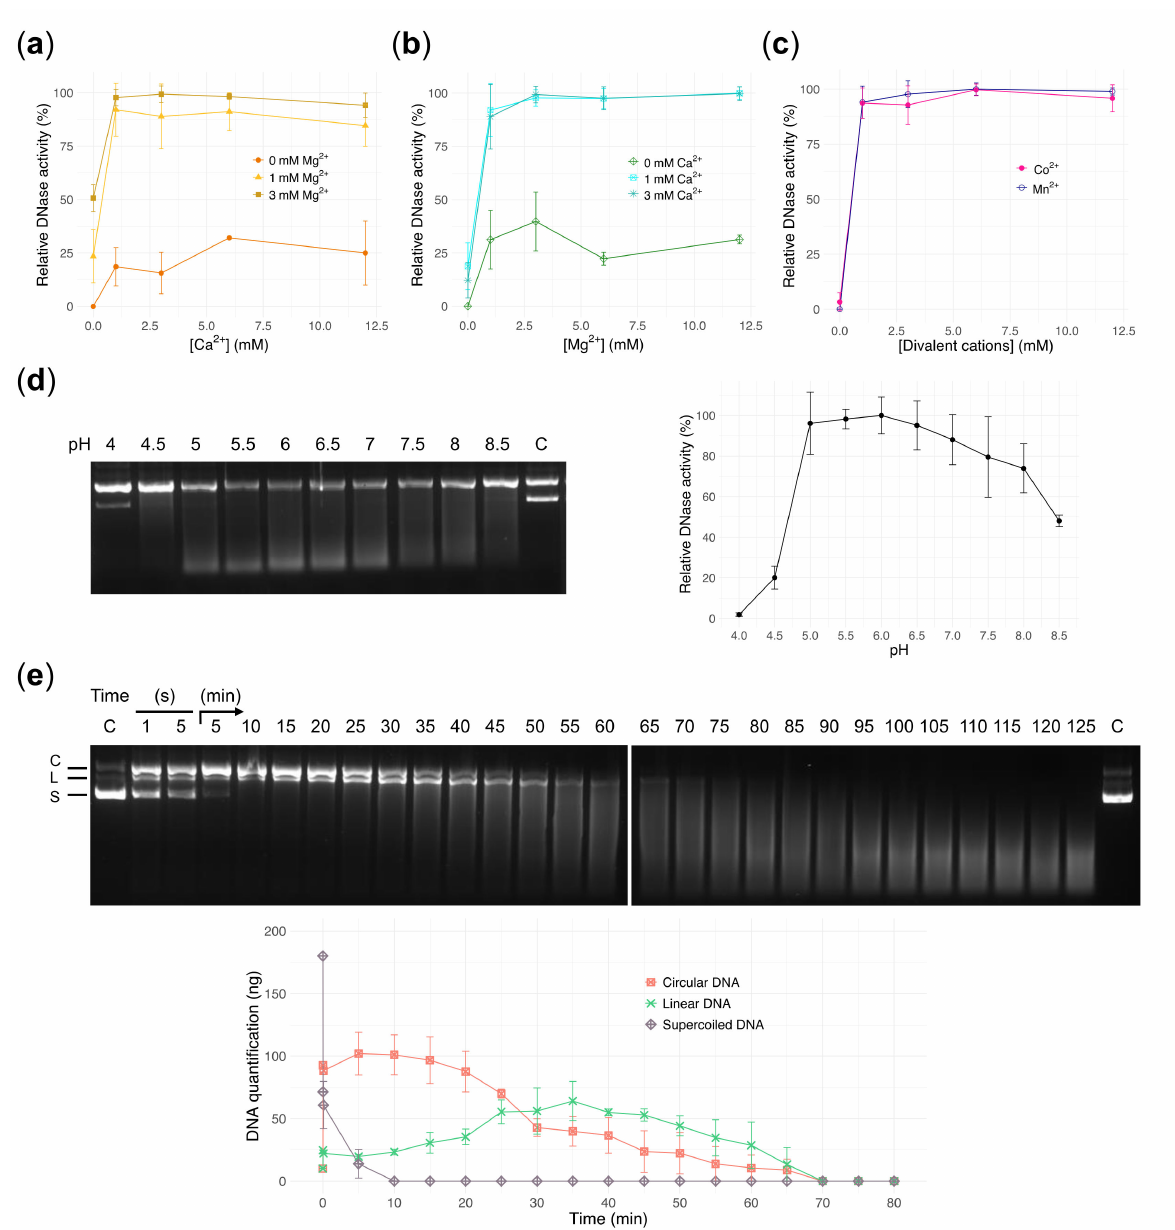
Figure 2. Characterization of DNase1L2 activity using purified plasmid DNA. ( a – c ) Gel densitometric analysis showing the effects of divalent cations on DNase1L2 activity. Data are means ± SD of three independent experiments. ( a ) Calcium titration in the presence of 0, 1, and 3 mM MgCl 2 . ( b ) Magnesium titration in the presence of 0, 1, and 3 mM CaCl 2 . ( c ) Manganese titration and cobalt titration. ( d ) Agarose gel electrophoresis (left panel) and densitometric analysis (right panel) showing the effect of pH on DNase1L2 activity. C: control, plasmid DNA without enzyme at pH 4. Data are means ± SD of three independent experiments. ( e ) Agarose gel electrophoresis (upper panel) and densitometric analysis (bottom panel) showing the time course of DNase1L2 activity. Plasmid DNA (200 ng; 90% supercoiled) was incubated with DNase1L2 (69 pmol) in the time range from 1 s to 125 min. C: control, supercoiled plasmid DNA without enzyme. Plasmid DNA forms are indicated at the left of the gel and correspond to the plots in the graph; C: circular DNA, L: linear DNA, S: supercoiled DNA. Data are means ± SD of two independent